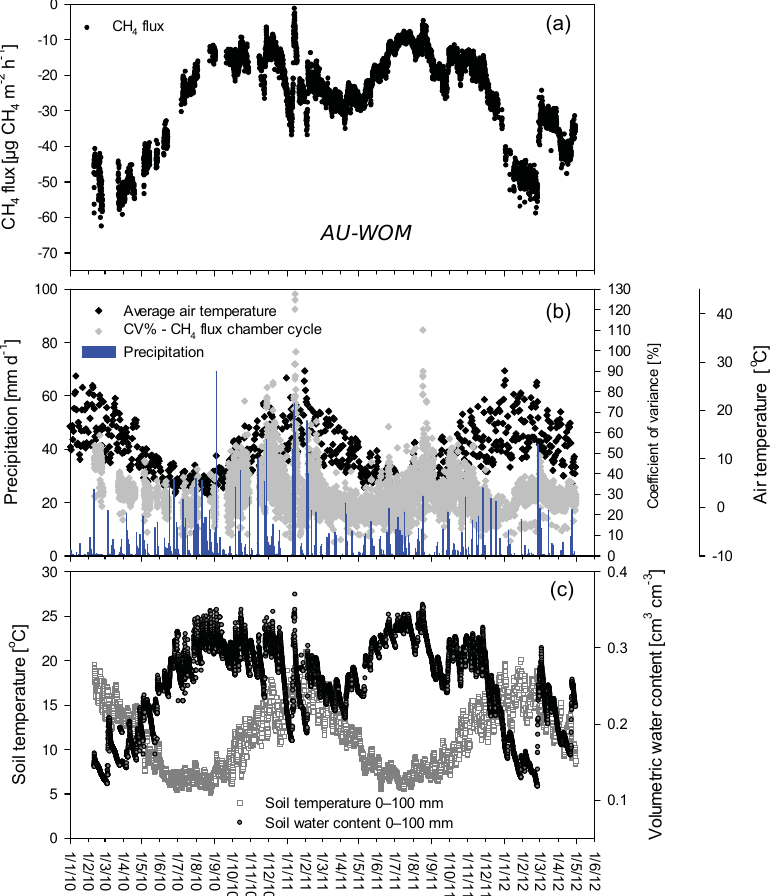
Figure 3. Soil-based flux of CH 4 at a mixed Eucalyptus obliqua forest stand, Wombat State Forest, Victoria, Australia (AU-WOM). Panel (a) shows CH 4 flux cycle means of six chambers measured within a 2h time period. Panel (b) shows site air temperature aver- aged over the chamber cycle period (black diamonds), daily rainfall sums (blue bars) and coefficient of variance of the CH 4 flux cycle mean shown in (a) (grey diamonds). Panel (c) shows soil temperature in the top 0–10cm averaged over each chamber cycle (grey squares) and corresponding soil volumetric water content (black/grey circles) at the site.